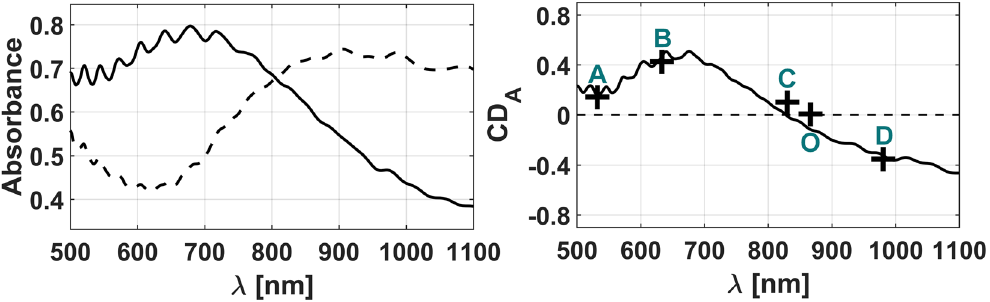
Figure 5. ( a ) Average absorption levels (dashed for Left CP and straight for Right CP) for periodic triple turn helices aligned with LP = 700 nm, and featuring a central line described by the equations in (4), with VP = 300 ± 10 nm, WD = 110 ± 10 nm, ED = 300 ± 20 nm, θ 0 = 6 π * (0.9 ± 0.06), p = 10 ± 0.7. ( b ) Corresponding CD A spectrum as defined in (3); {A, B, C, D} indicate the CD A values measured by means of the PA technique, while O indicates the AO crossing